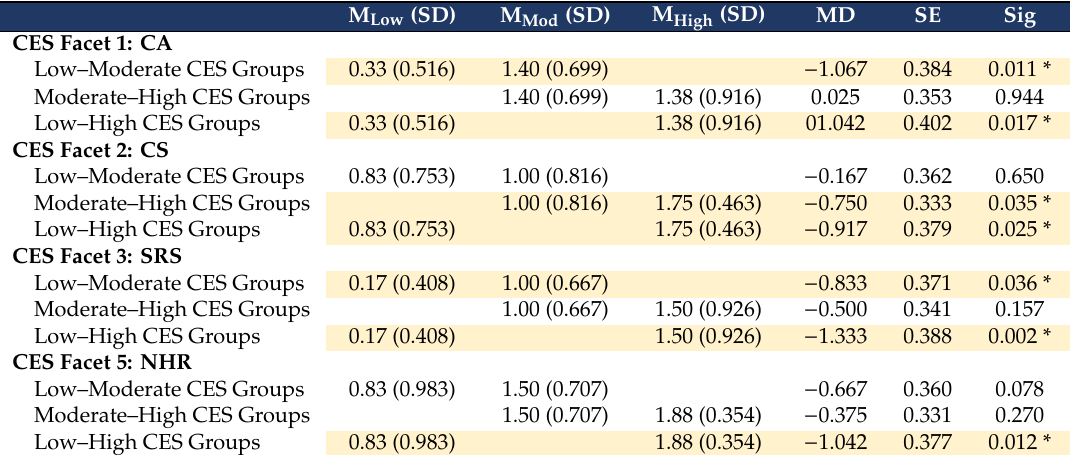
Table 3. Tukey Post Hoc